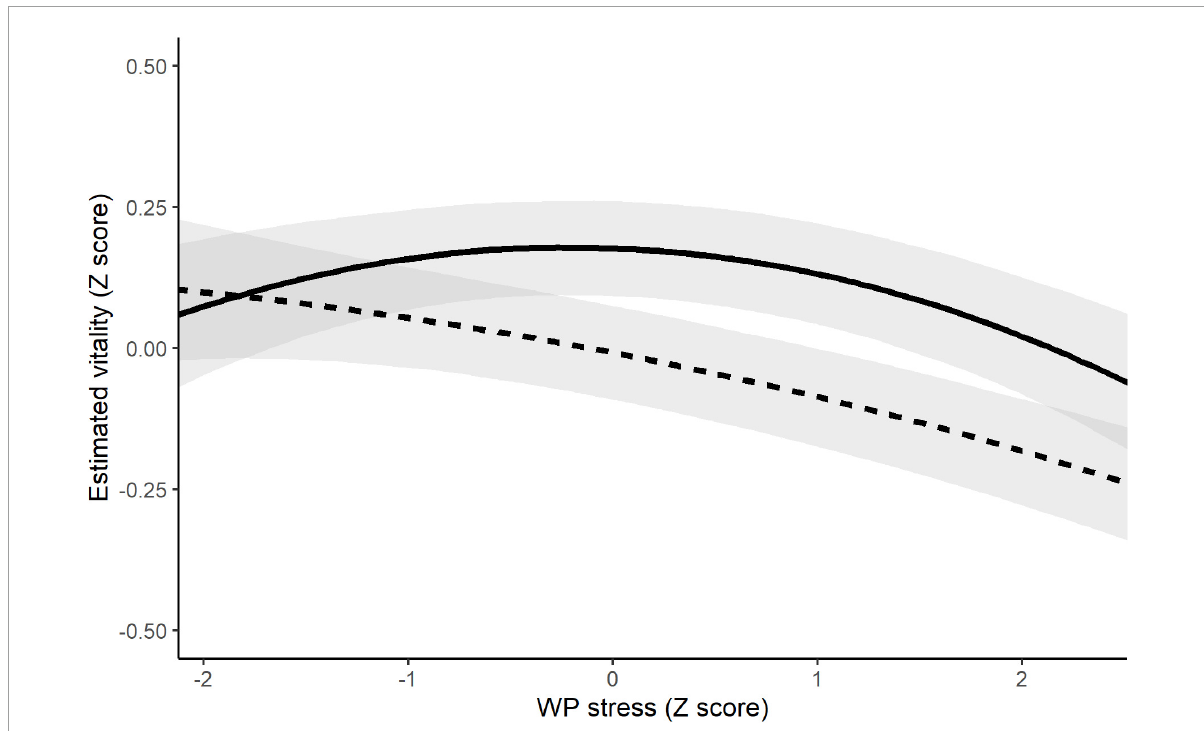
FIGURE4 Interaction of quadratic WP Stress severity × WP AARC-losses in the prediction of vitality. The dashed line represents the association of WP stress with vitality at occasions when AARC-losses was higher (+ 1 SD ) relative to the person-mean across days. The solid line represent the association of WP Stress with vitality on occasions when AARC-losses was lower ( − 1 SD ) relative to the person-mean across